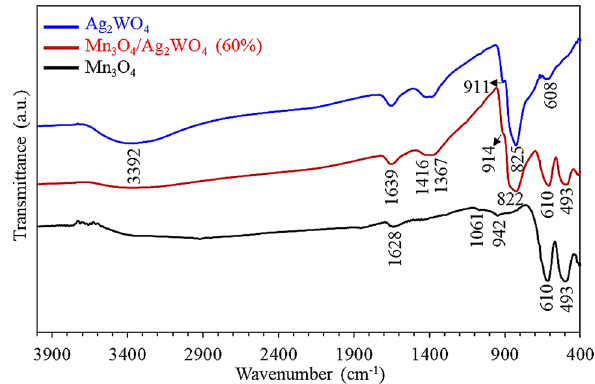
Figure 4. FTIR spectra of α-Ag 2 WO 4 , Mn 3 O 4 and Mn 3 O 4 /α-Ag 2 WO 4 (60%).